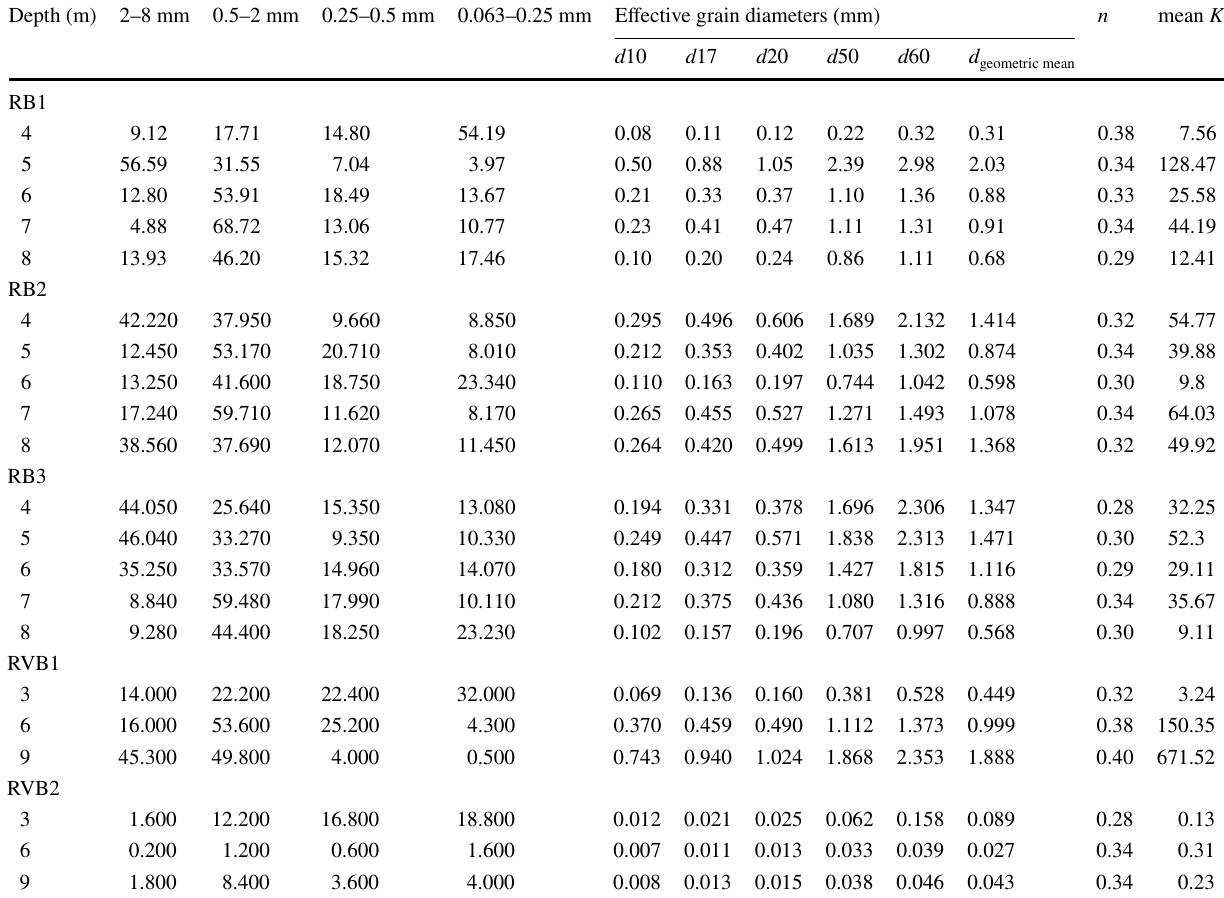
Table 6 Mean of K g value from empirical data for streambed (right, left and middle of river) until 8 m